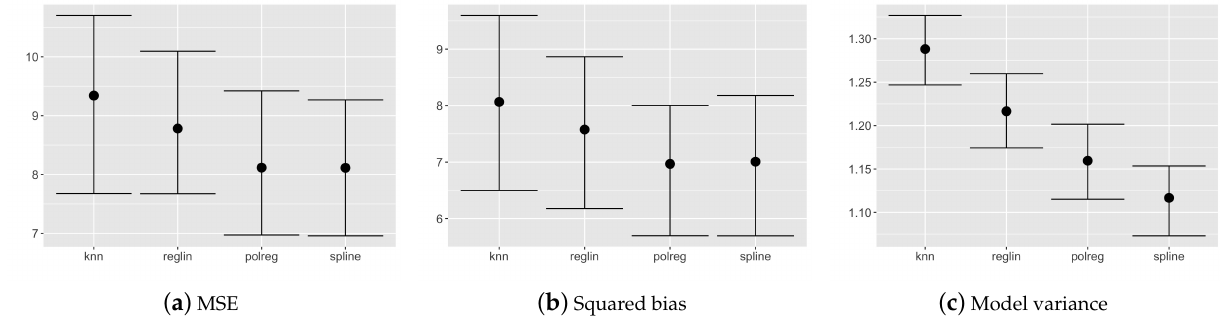
Figure 2. Comparison of nonparametric confidence intervals for mean squared error (MSE), squared bias and model variance related to the validation set for different prior choices on the relation among dependent and independent